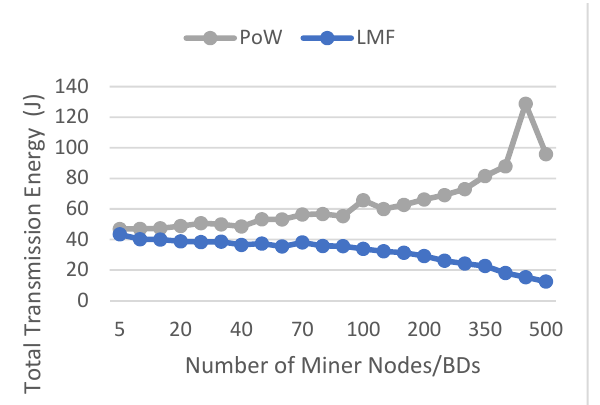
Figure 18. The total transmission energy vs. the number of nodes in the PoW and LMF models.